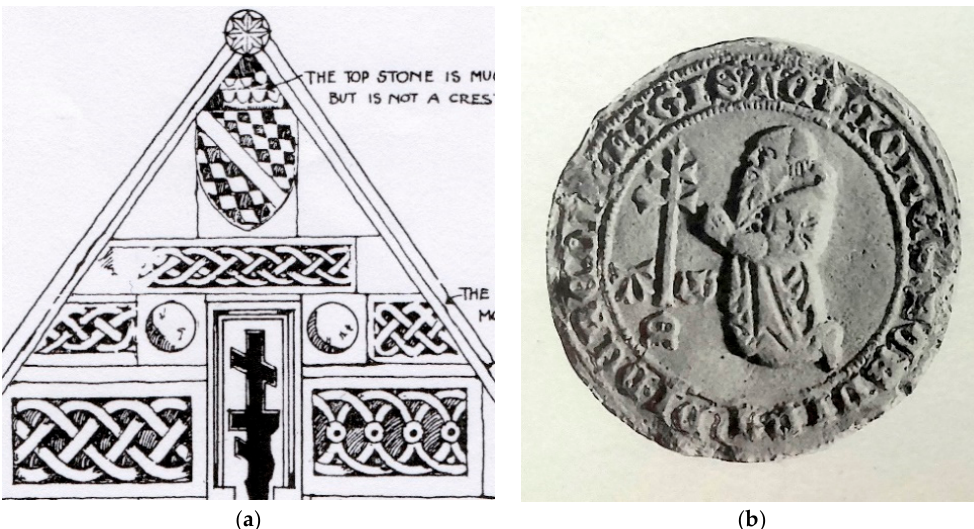
Figure 36. ( a ) Upper part of the stone gabled aedicule with the shield of Alfaro and the Patriarchal Cross of Jerusalem, chapel of Hagios Georgios in the castrum of Geraki, north aisle, drawing. Source: (Traquair 1905–1906) l; ( b ) Juan Fernández de Heredia kneeling and praying before the Patriarchal Cross of Jerusalem, seal of a bull of the Order of St John of Jerusalem issued in Rhodes during the rule of Juan Fernández de Heredia (1377–1396). Source: (Schlumberger et al. 1943).